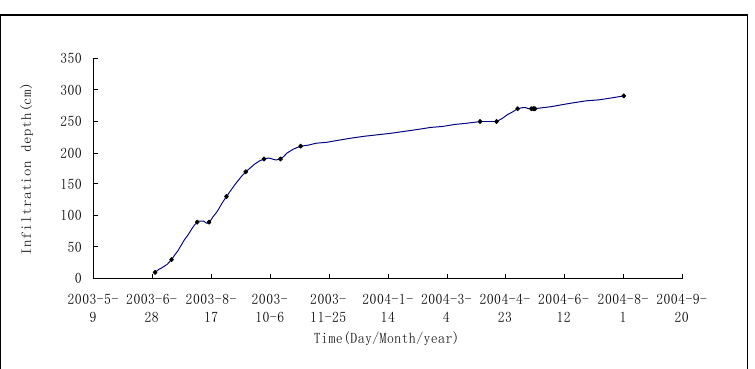
Figure 4. Change in the cumulative infiltration process with increasing time in caragana korshinskii shrubland in the semiarid and hilly Loess region (Guyuan, China).